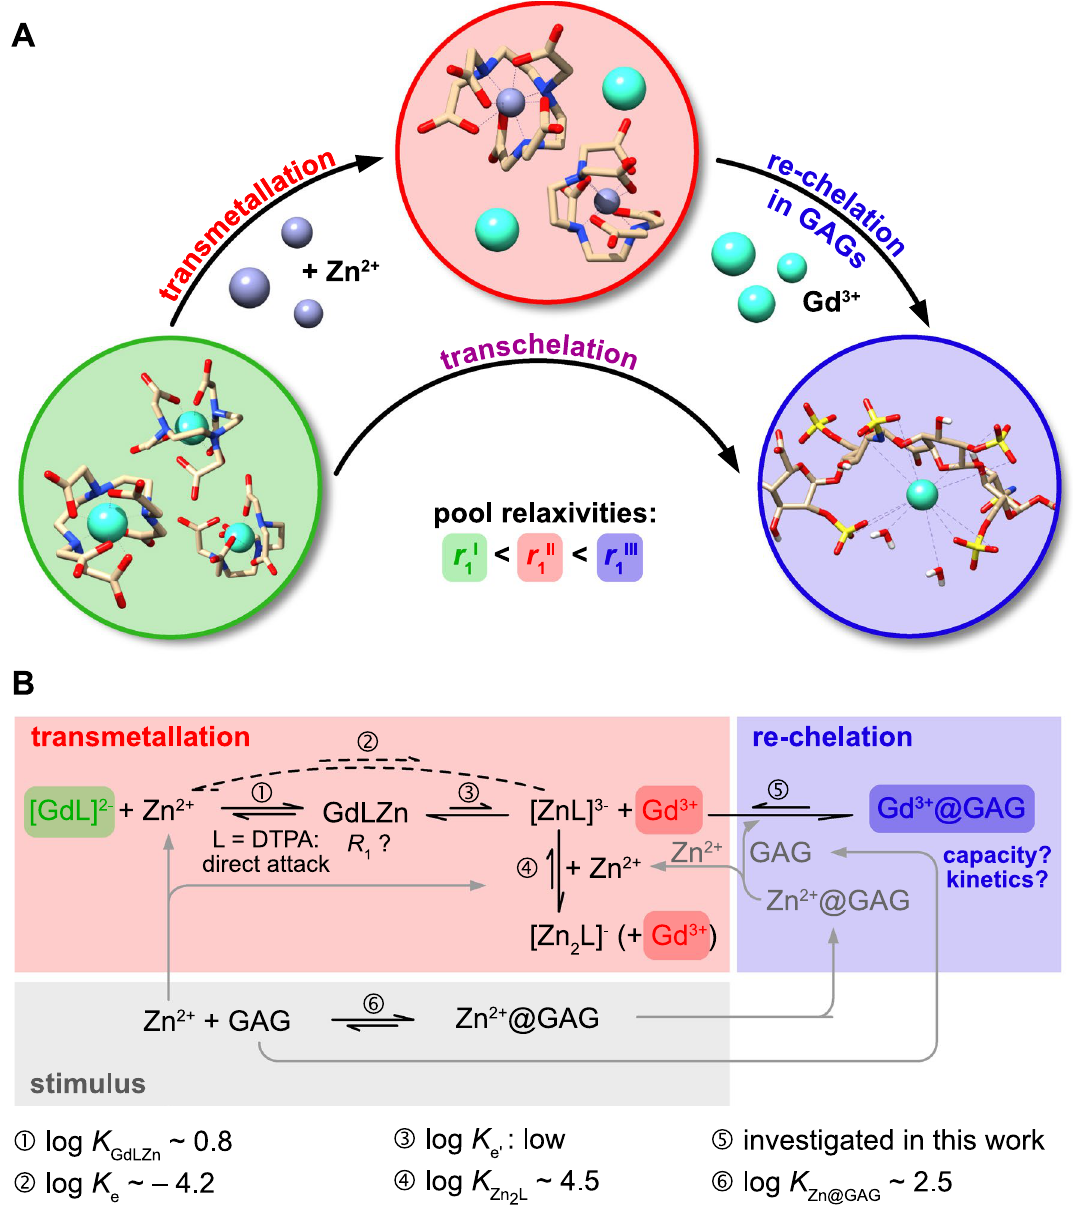
Figure 1. Stepwise zinc-induced rearrangements of chelated Gd in the presence of competing macromolecular chelators like the GAG heparin. The three distinct relaxivities for following Gd 3+ through the process steps, r 1I , r 1II , r 1III , are key to quantitative analysis. ( A ) In the transmetallation step, the central Gd 3+ ion in the parent GBCA complex is replaced by Zn 2+ (the intermediate Zn 2+ complex is shown). Subsequently, the dissociated Gd 3+ ions bind into the GAG structure. Coordination of the Gd 3+ ion in the GAG structure is only schematic and was not calculated. ( B ) Details of the involved chemical equilibria. Zn 2+ and GAG serve as stimulus where Zn 2+ can also interact with the GAG matrix. For linear chelators, Zn 2+ directly attacks the ligand L and initially forms a hetero dinuclear complex GdLZn as an intermediate with moderate stability. The transmetallation to ZnL with release of Gd 3+ (no further additives) is thermodynamically unfavored (the dashed direct reaction does not occur but the net equilibrium constant K e is known). Thus, the release of Gd from GdLZn must occur with low equilibrium constant K e ‘. For efficient release of Gd 3+ and to keep L blocked, the second intermediate ZnL + Gd 3+ should be converted. To render the reaction irreversible and prevent Gd 3+ binding to L, additional Zn 2+ (provided directly or indirectly from the stimulus) can form the more stable Zn 2 L complex. Moreover, the GAG can serve to sequester Gd 3+ and thus prevent re-formation of GdLZn. The parameters for equilibrium ➄ are unknown, i.e., the “capacity” of the GAG pool to scavenge Gd 3+ as well as the time it takes to reach a new steady state. Equilibrium reaction arrows and stability constants are given only for qualitative orientation summarizing values at ~ 25 °C from (17, 36,